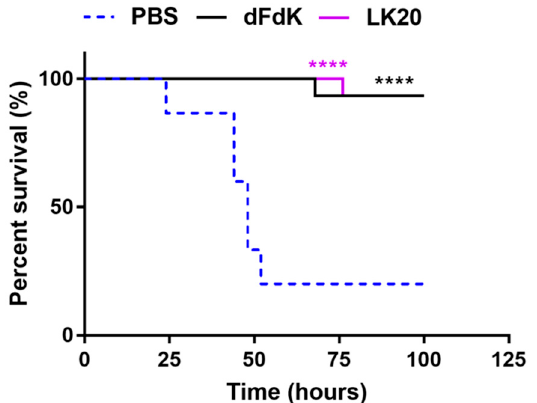
Figure 7. Random peptide mixtures (RPMs) attenuate mouse mortality during sepsis infection. CD1 mice (cohorts of 15) were retro-orbitally-infected with A. baumannii strain W41979 (9.65 × 10^7 CFU). Infected mice were treated with dFdK or LK20 (10 mg/kg) or sterile phosphate buffered saline (PBS) twice daily, for 3 days. Mouse survival was monitored for 100 h. **** p < 0.0001 were derived when comparing the mortality of infected mice treated with RPMs against those treated with PBS by using the Kaplan–Meier Log Rank (Mantel–Cox) survival test.